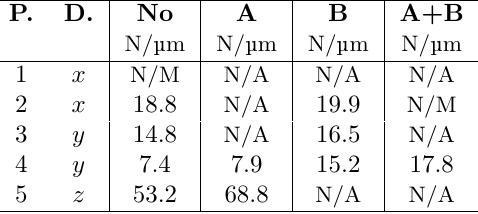
Table 9: 2-Axis trunnion: average stiffness without brake (No) and with A and B-axis brake com-